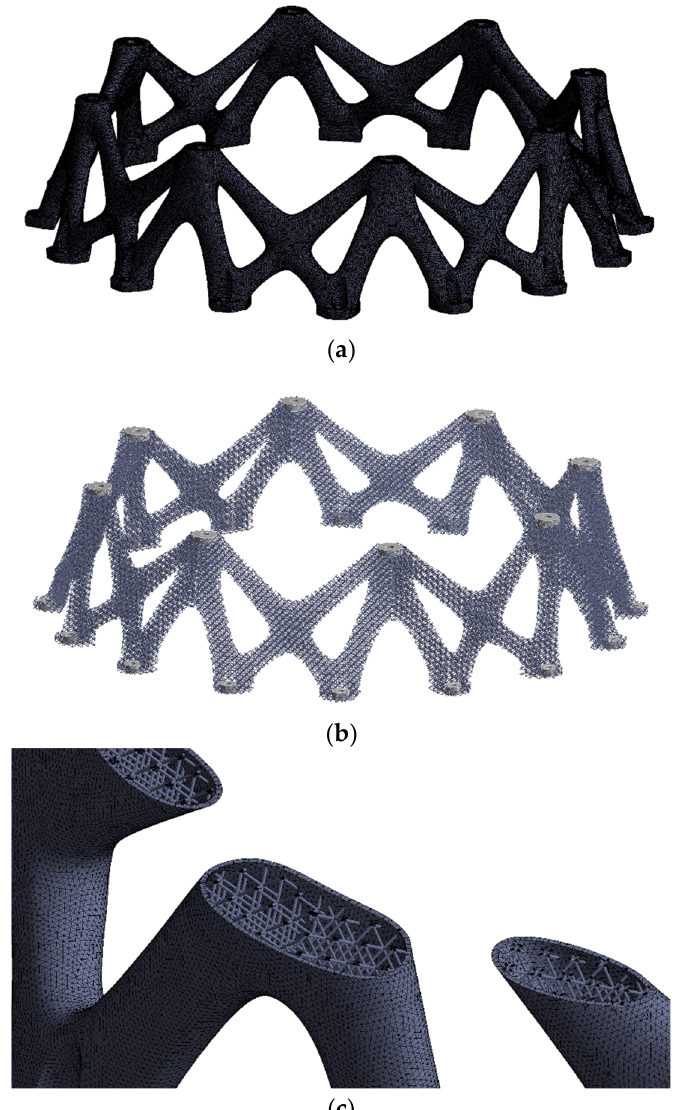
Figure 11. Detailed FEM model with a total of about 310,000 nodes: ( a ) entire model; ( b ) beam elements of lattice and solid elements of bolt holes; ( c ) internal view.